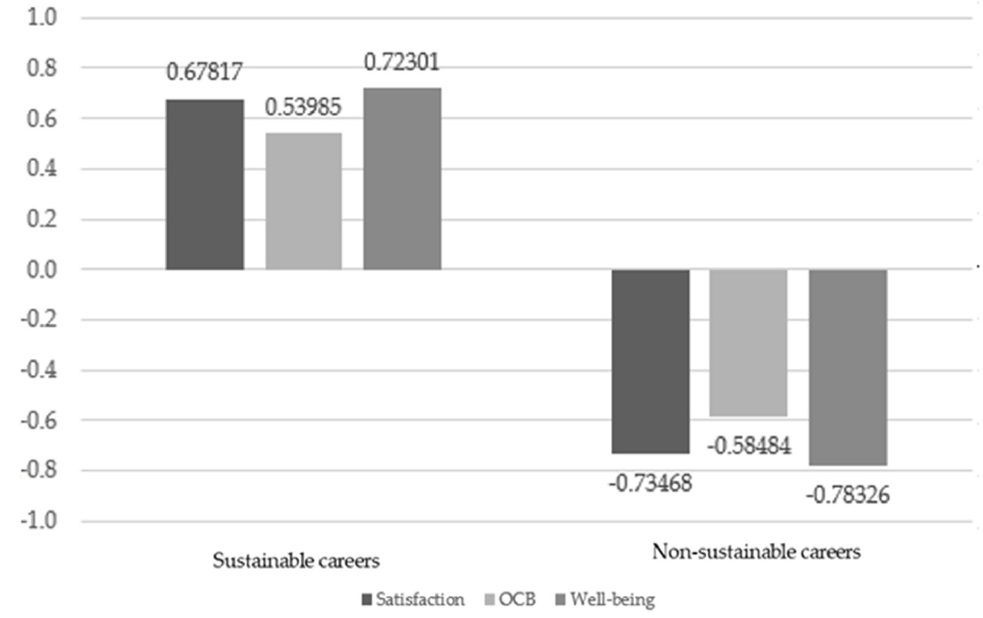
Figure 2. Two-cluster solution for sustainable career proxies.